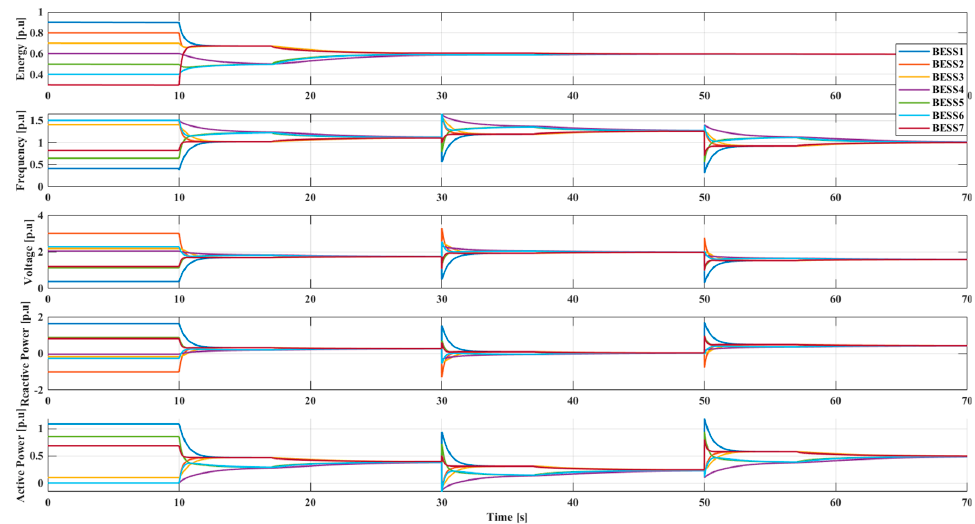
Figure 7. Simulation results of step-by-step consensus algorithm without the virtual leader (case 3).